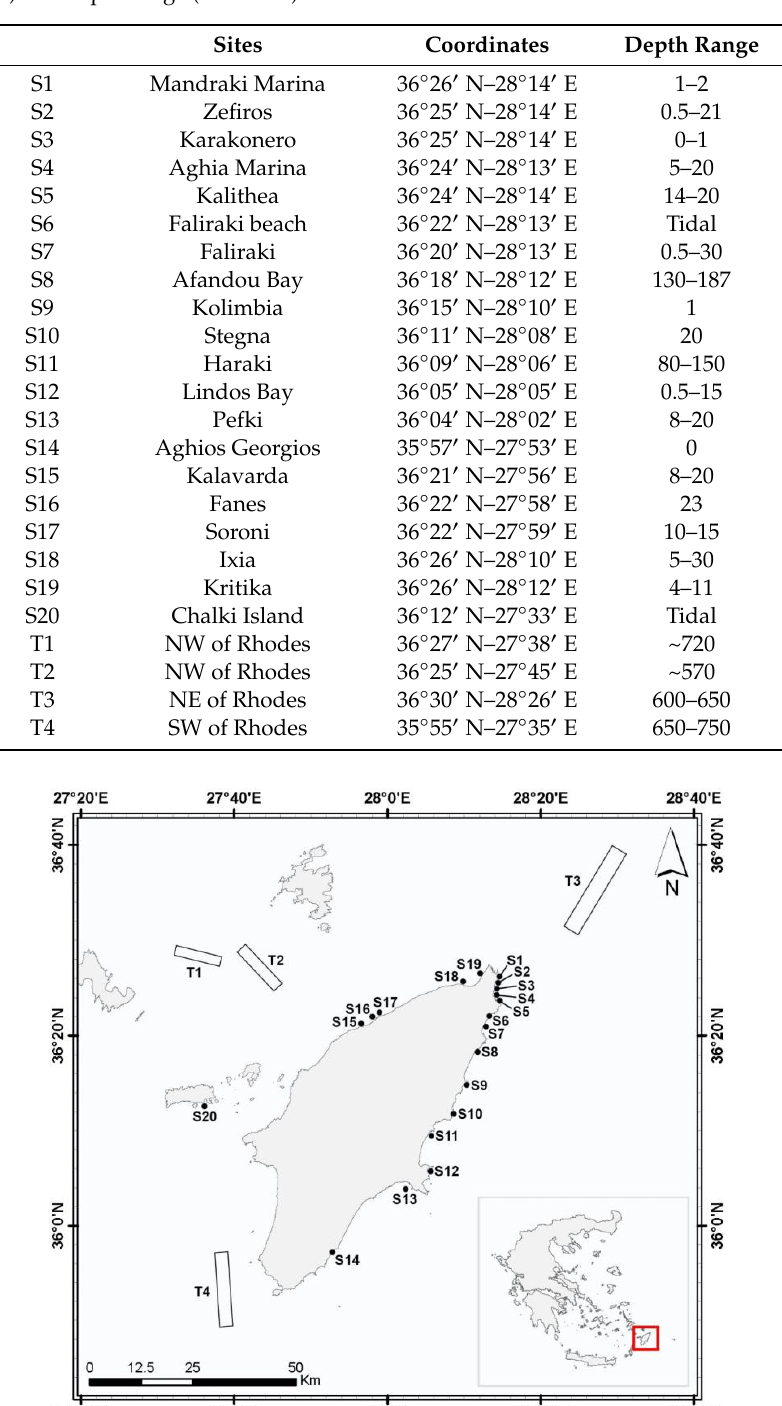
Table 1. Sampling sites and trawling grounds shown in Figure 1, with coordinates (rounded to degrees and minutes) and depth range (in meters).